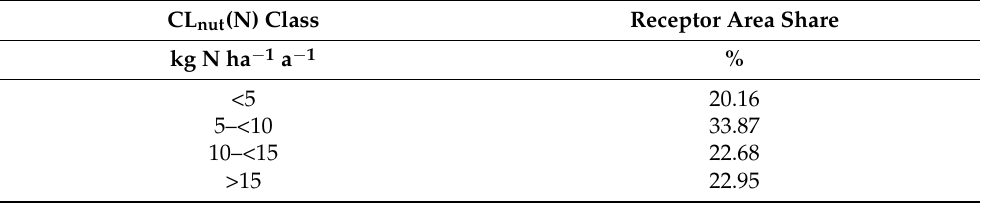
Table 22. Share of receptor areas in Germany in the classes of critical loads for eutrophying nitrogen inputs.